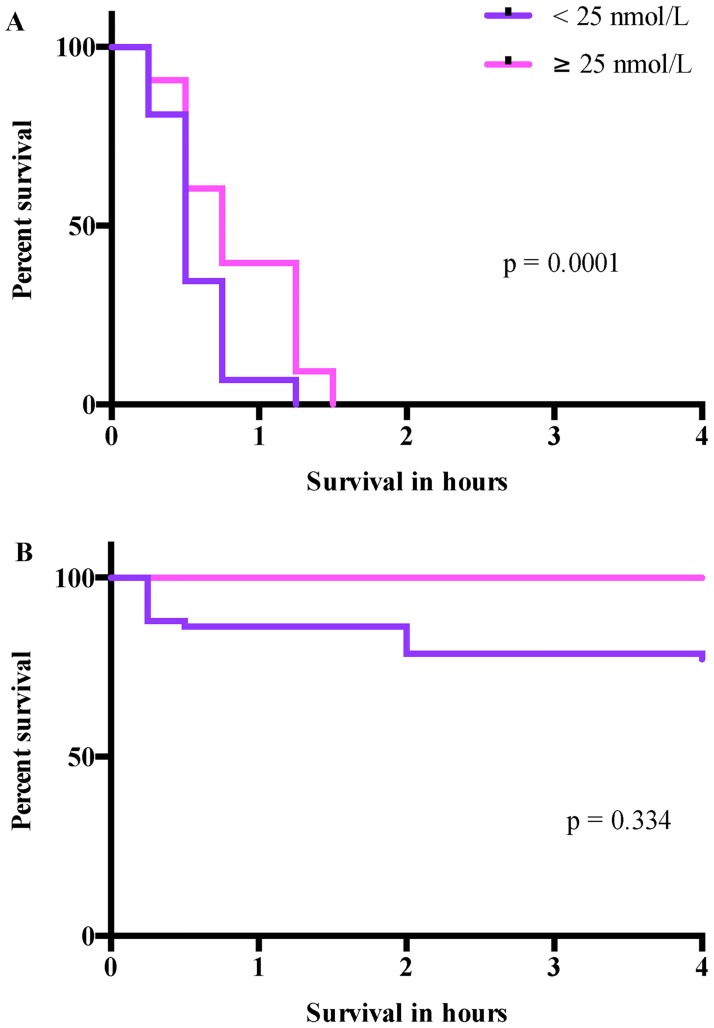
Survival-rate of pups from mothers stratified by s-25(OH)D <25 nmol/L.Kaplan-Meier survival analysis of both A) E19 (s-25(OH)D <25 nmol/L (n = 58); ≥25 nmol/L (n = 43)) and B) E22 (s-25(OH)D <25 nmol/L (n = 58); ≥25 nmol/L (n = 28)) pups. Comparison of survival curves using log-rank (Mantel-Cox) test.